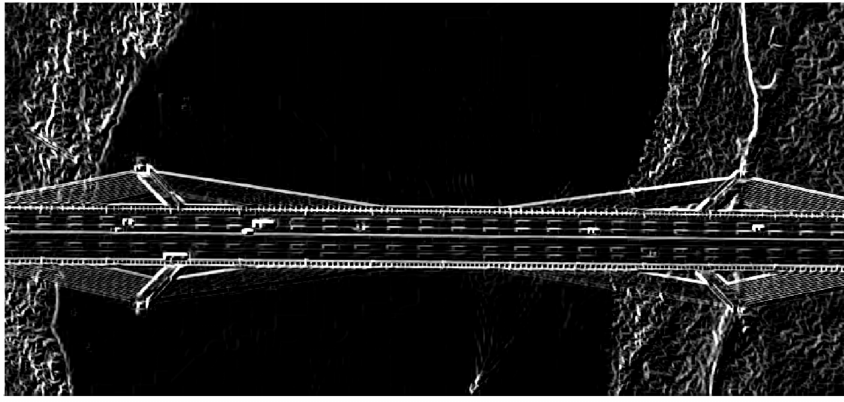
Figure 7. Modulus image.